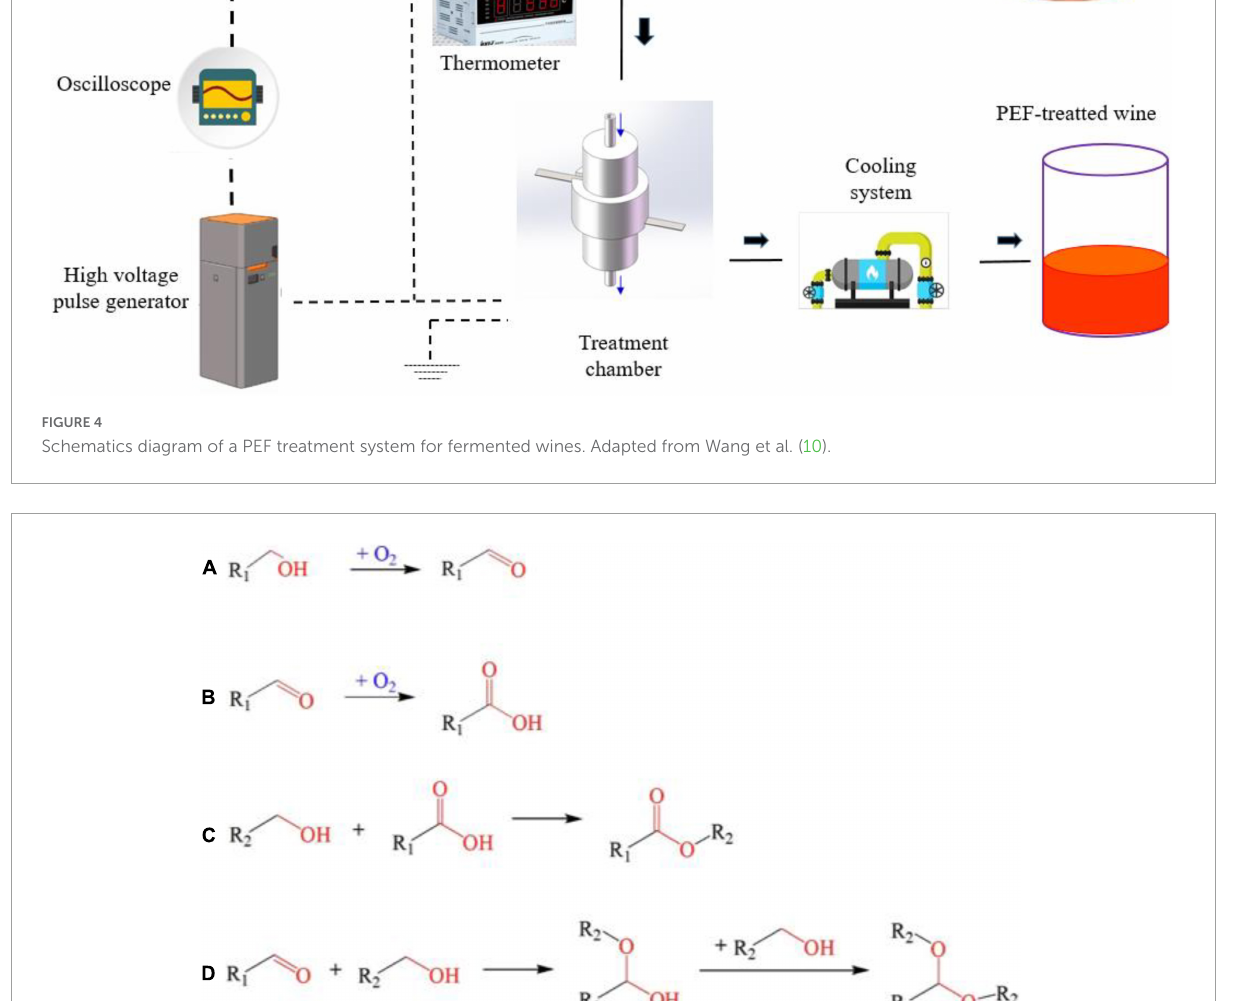
with red wine resulted in the evolution of L-malic acid, citric acid, and succinic acid concentrations following similar trends to bottle aging (10). The variation trends of citric acid, oxalic acid, and succinic acid in naturally aged white wines, were similar to those of white wines treated by PEF (6 kV/cm, 100 pulses) ( Table 1 ). The amount of L-malic acid in the wine treated by PEF of 6 kV/cm and 100 pulse numbers was near